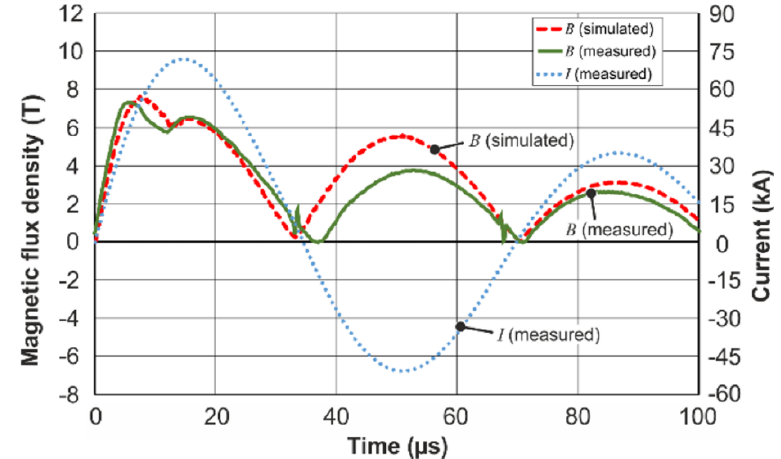
Figure 6. Magnetic field dynamics during the welding of an aluminum tube of wall thickness d = 2 mm with the steel parent. Scaled LS-DYNA simulation (scaling factor 0.3 is the red dashed line), the measurement is the green line and the current oscillations through the coil are the blue dotted